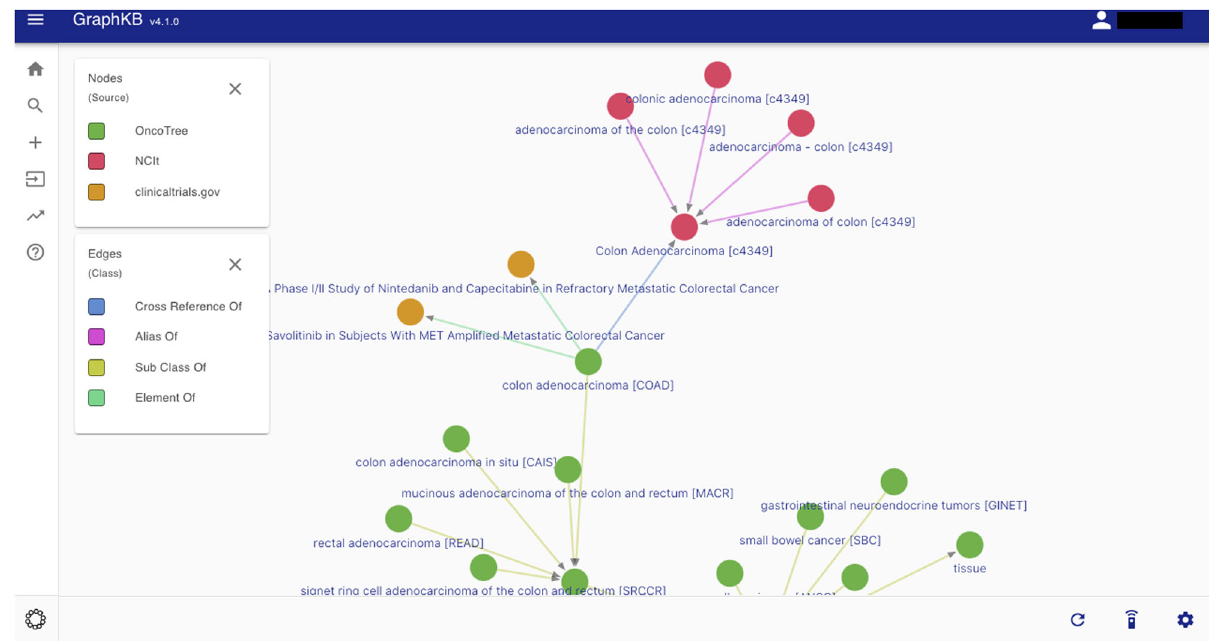
Fig. 5 Graph view of content in the GraphKB web application. A subset of links between disease terms related to colorectal adenocarcinoma are shown from NCI thesaurus (NCIt) and OncoTree. For brevity, only a small number of links to clinical trials (Clinicaltrials.gov) are shown.